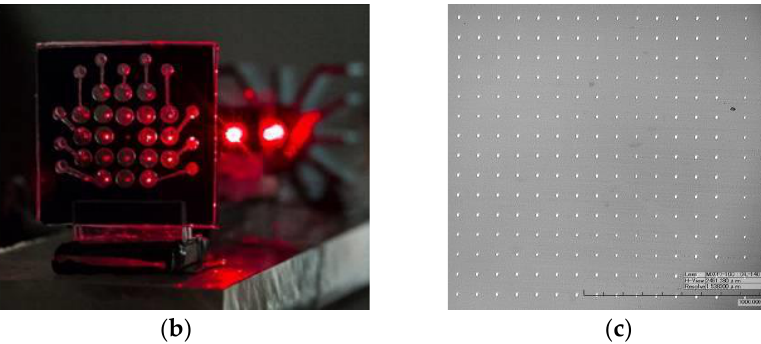
Figure 5. Experimental assembly of the matrix chip ( a ); a matrix chip in the installation illuminated by laser beams transmitted through the grating ( b ); and a micrograph of the diffraction grating from anodic alumina ( c ), where the window diameter is 10 μm and the distance between the windows is 100 μm.